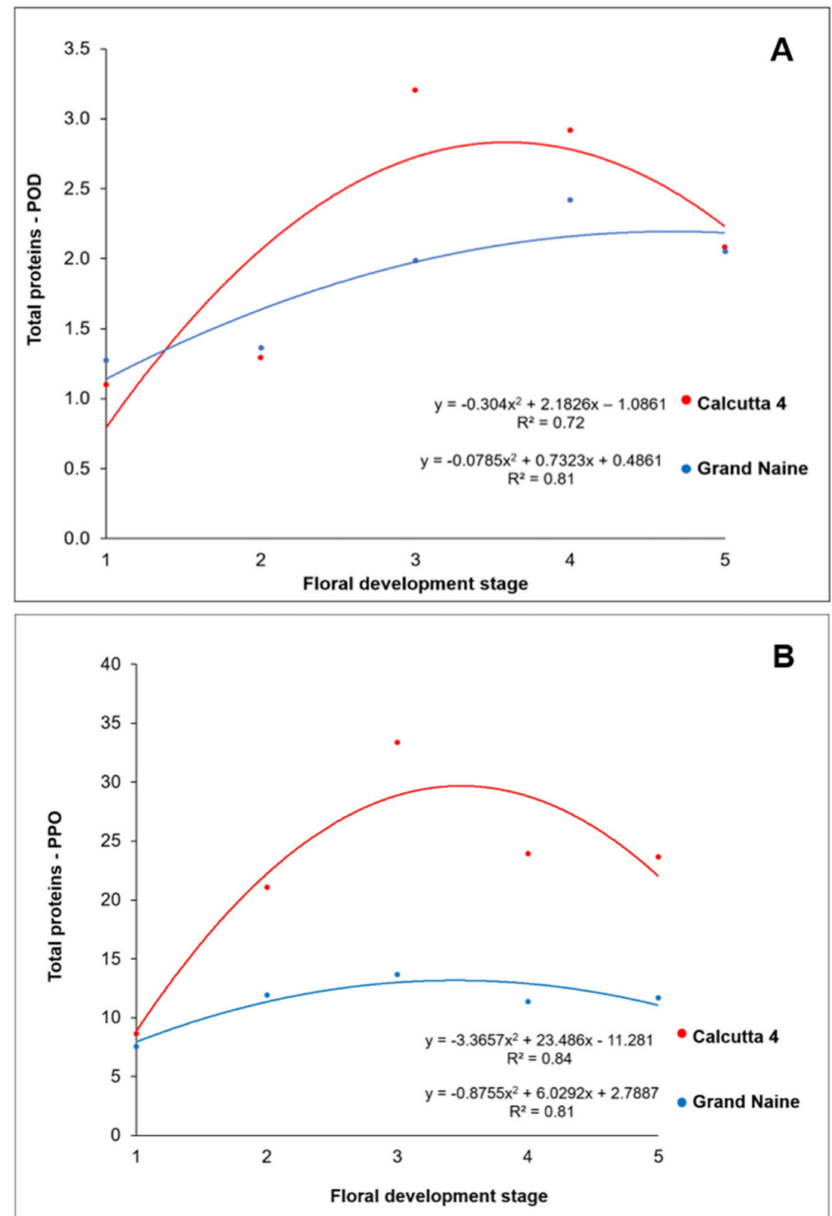
Figure 4. Protein content assay through the enzymatic activity of ( A ) peroxidase (POD) and ( B ) polyphenol oxidase (PPO) per gram of protein at different stages of floral development in Calcutta 4 and Grand